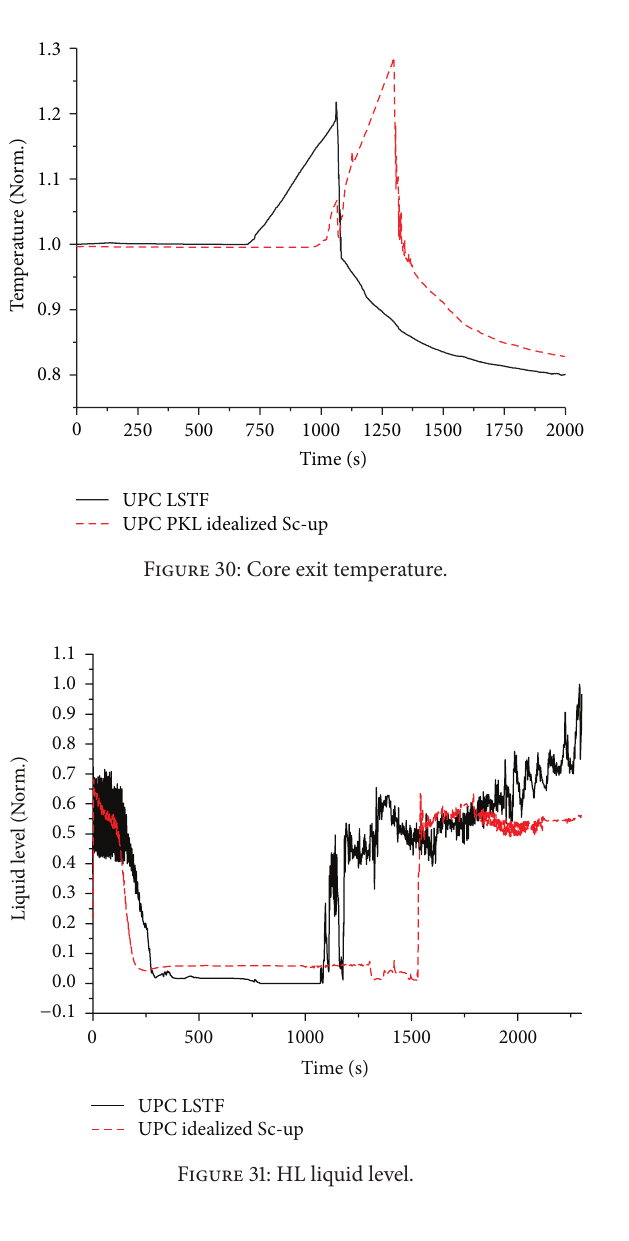
Figure 31: HL liquid level.